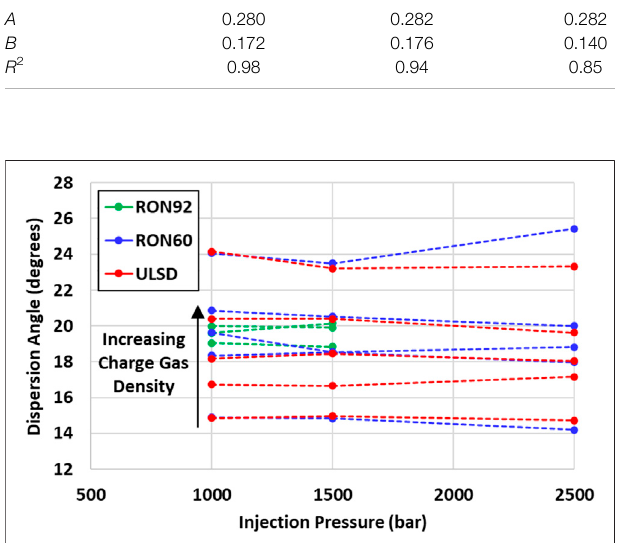
FIGURE 14 | Non-vaporizing dispersion angle vs. injection pressure at different charge gas